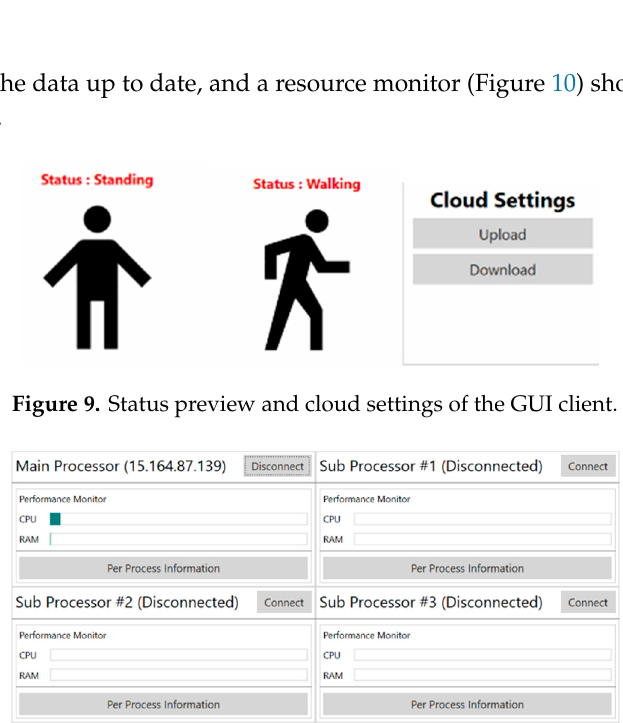
Figure 10. Resource monitor of the GUI client.